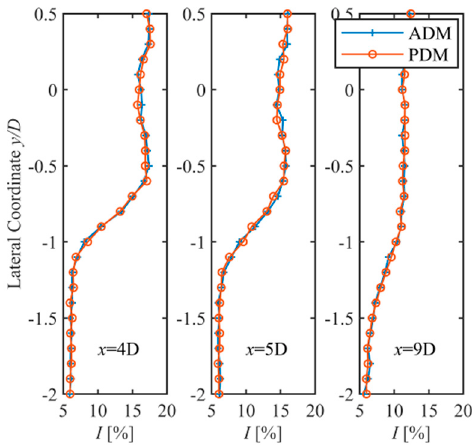
= 4 in the ABL wind Figure 11. Turbulence intensity distributions in the ADM and PDM at λ = 4 in the ABL wind tunnel. Figure 11. Turbulence intensity distributions in the ADM and PDM at λ Figure 11. Turbulence intensity distributions in the ADM and PDM at λ = 4 in the ABL wind tunnel. Figure 11. Turbulence intensity distributions in the ADM and PDM at λ = 4 in the ABL wind tunnel.